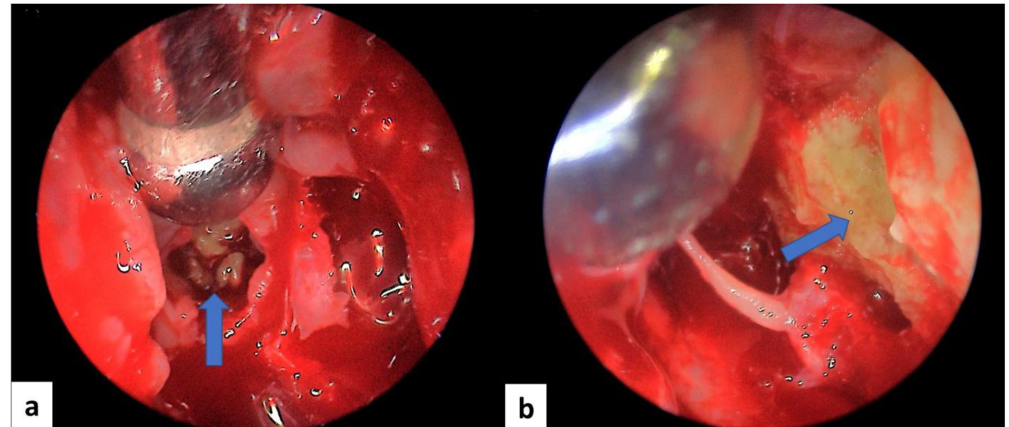
Figure 3. Intraoperative endoscopic view of a case of allergic fungal rhinosinusitis: mucin (blue arrow) within ethmoidal cells ( a ) and of the left maxillary sinus ( b ).